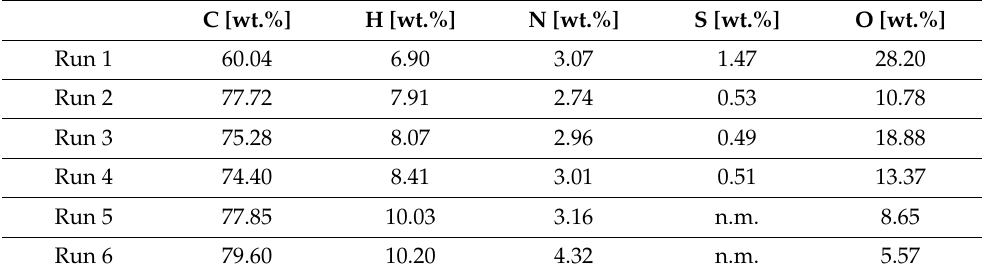
Table 3. Overview of quantified HTL biocrude sample constituents: carbon, hydrogen, nitrogen, sulfur, and